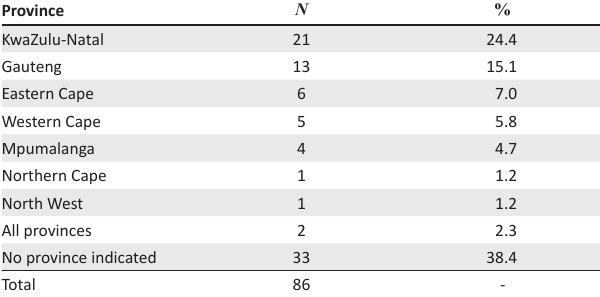
FIG URE 1: Number of respondents per category (multiple responses TABLE 1: Provincial and national representation of respondents ( N = 53).